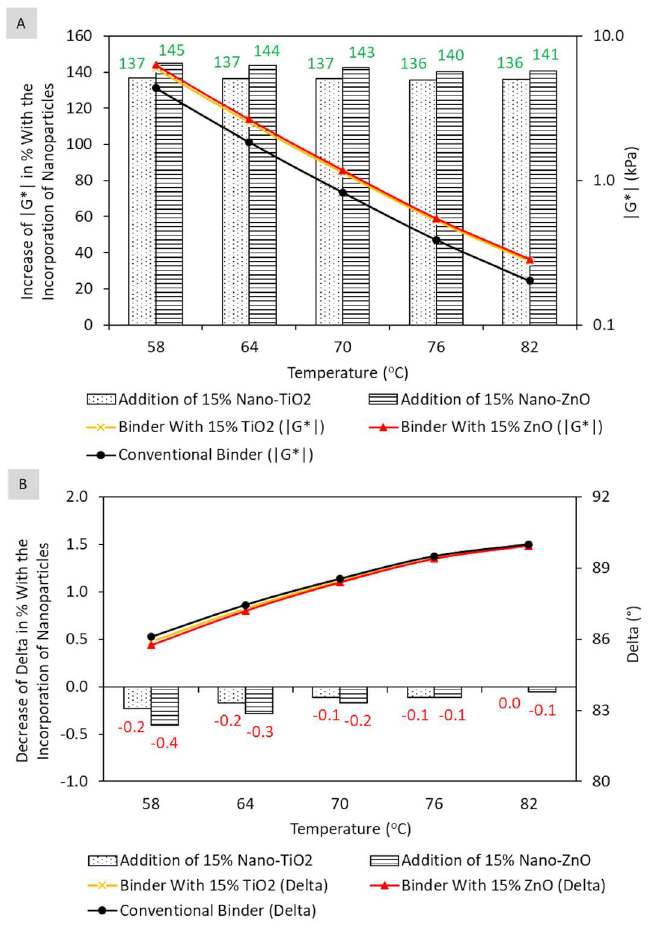
Figure 6. Influence of the incorporation of 15% of nanoparticles on the dynamic shear modulus (|G*|) ( A ) and phase angle (δ) ( B ) of the asphalt matrix aged in the short term at high temperatures.